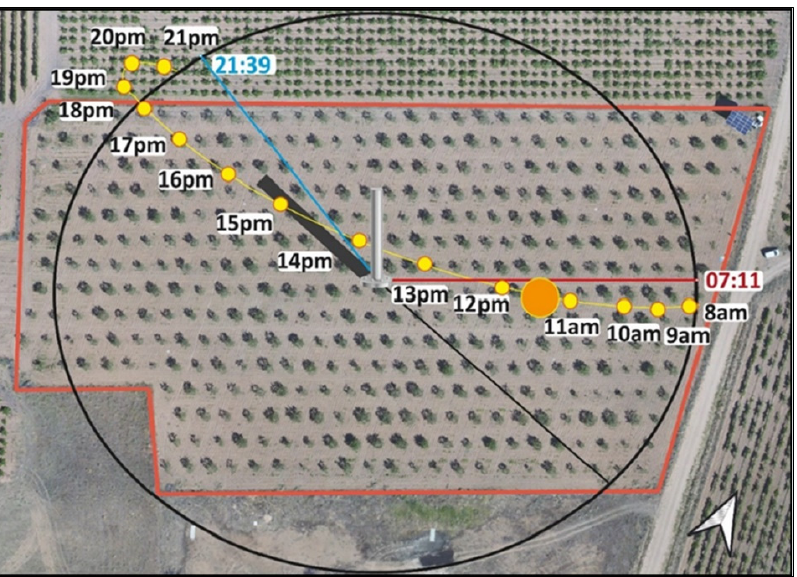
Figure 7. Position of the sun throughout the day at the experimental site. Red polygon: UAV flight area.